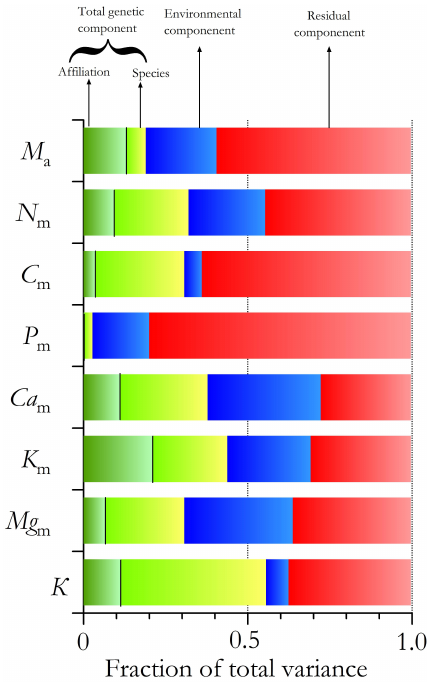
Figure 5. Partitioning of the total variance for mass-based foliar properties into genetic (green), environmental (blue) and residual (red) components with the genetic component further divided into the variations between versus within vegetation formation affilia- tion (each species having being identified as principally associated with either forest or savanna). M a denotes mass per unit area and K represents leaf construction costs. Other symbols represent the elemental composition of the leaves on a dry-mass (subscript “m”)